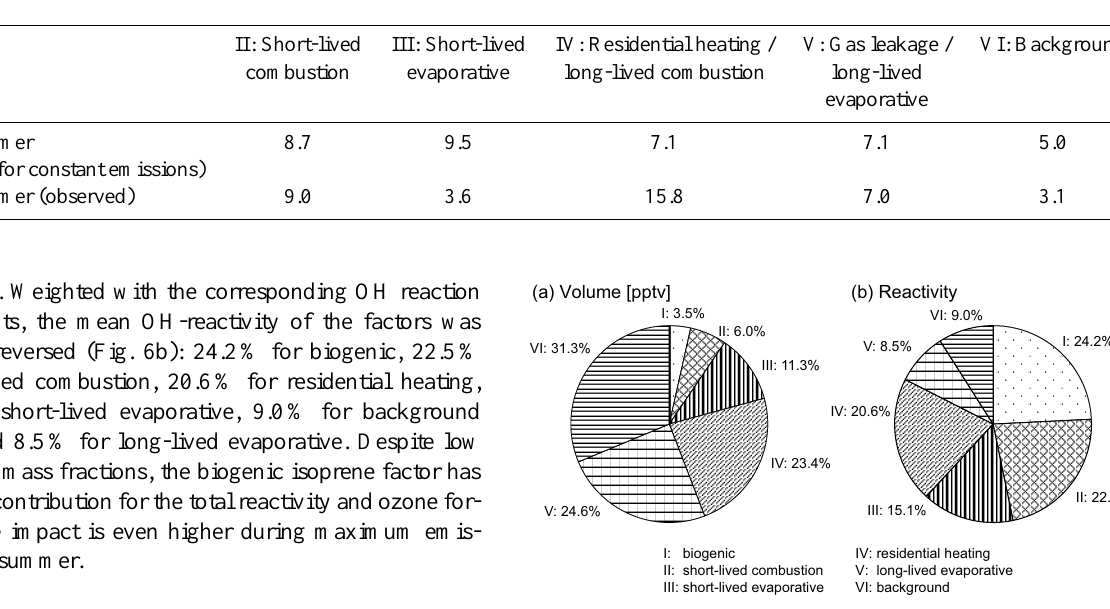
Table 4. Comparison of the calculated winter/summer ratios from the box model with constant emissions and the observed winter/summer ratios for the PMF-factors.